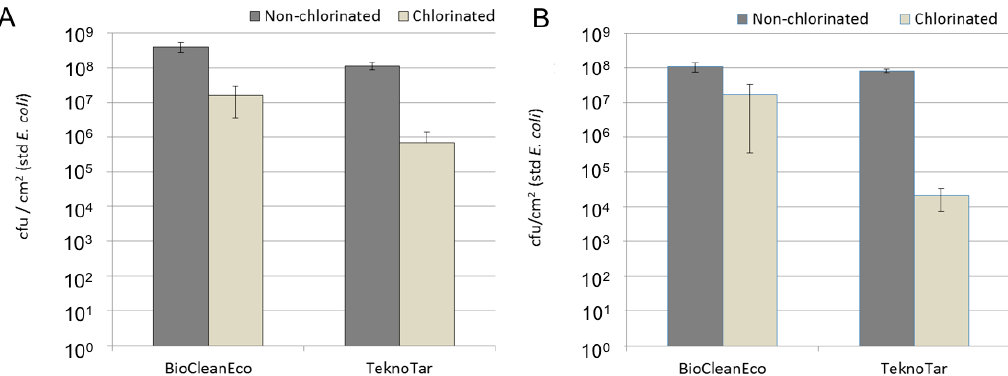
Figure 7. Numbers of bacteria on coupon surfaces after ( A ) one-month and ( B ) three-month exposure in control system or hypochlorite-treated sea water, as determined using quantitative PCR. Bars show standard deviations. cfu: colony forming units.